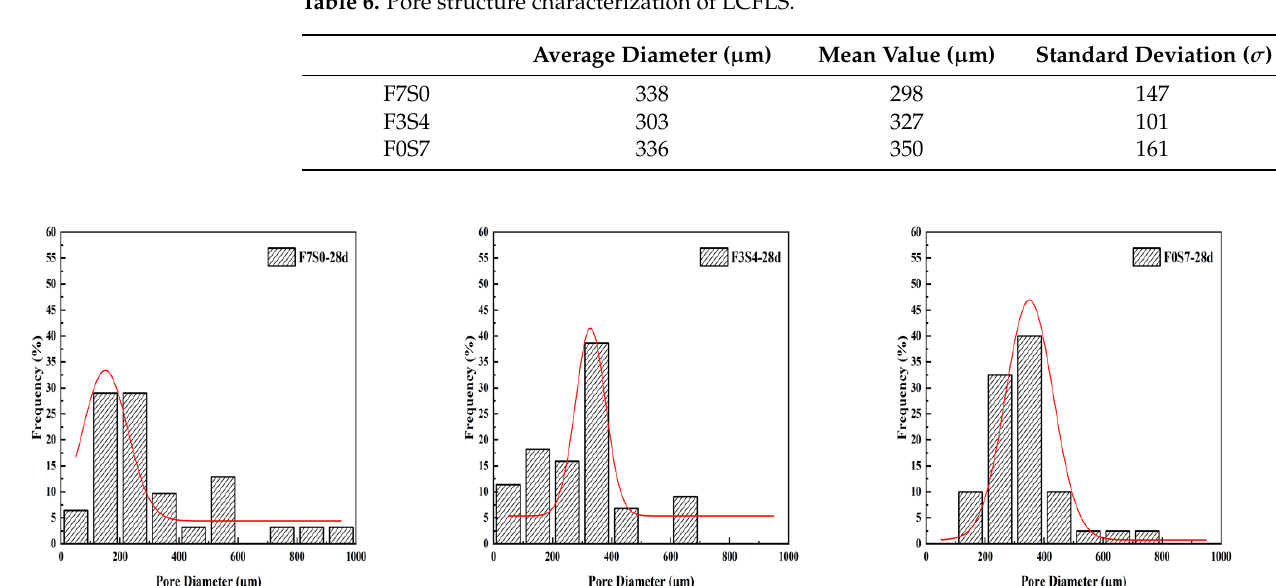
Figure 9. Pore size distributions of LCFLS.